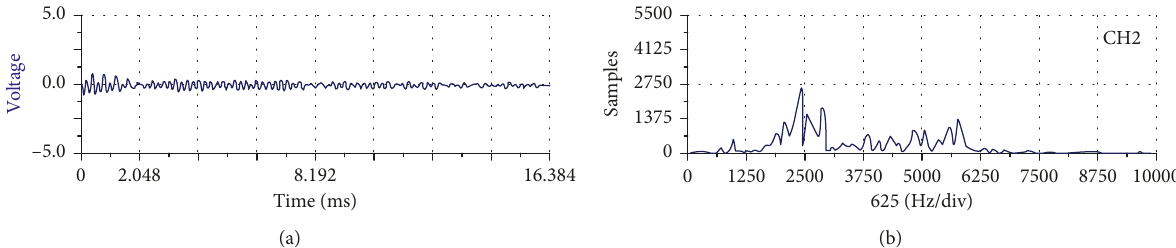
Figure 5: AE signal with no rub impact. (a) AE waveform in the time domain. (b) AE waveform in the frequency